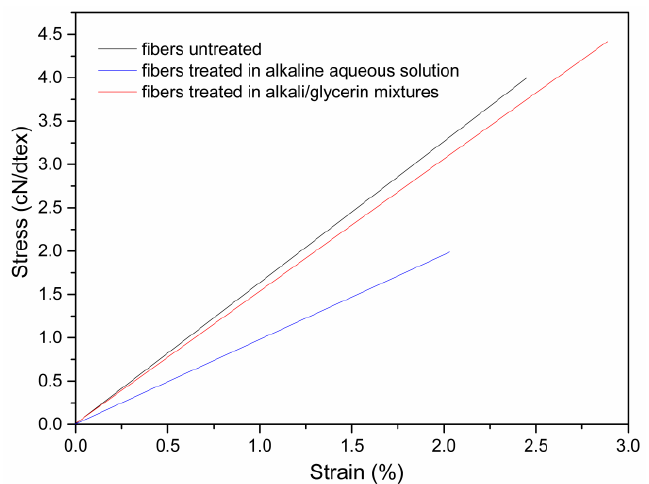
Figure 5. Stress–strain curves of the fibers treated in the alkali/glycerin mixtures compared with those of the fibers treated in the alkaline aqueous solution.